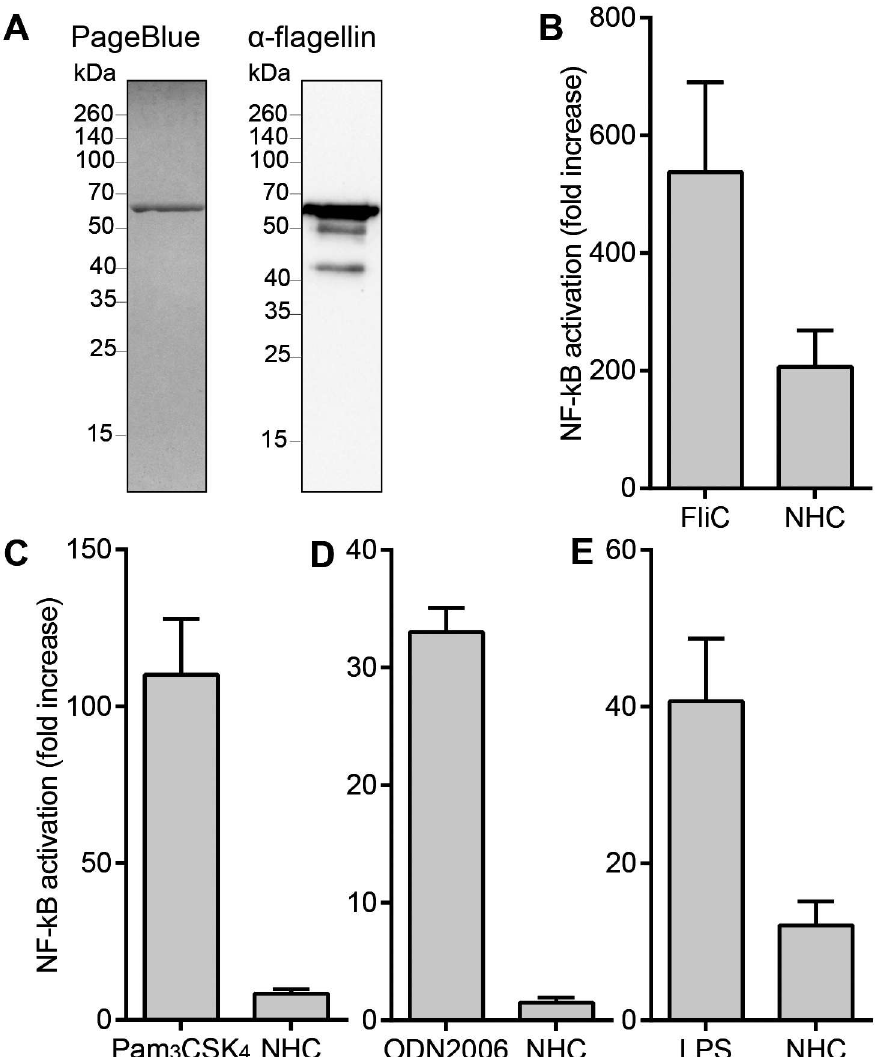
Fig 1. Quality properties of the NHC vaccine. ( A ) The NHC protein was analyzedby SDS-PAGE in combination with PageBlueProtein Staining and by Western blotting using a C . jejuni 81116 FlaA flagellin- specific antibody. ( B-E ) NF- κ B luciferaseactivity of HeLa57Acells expressing ( B ) chTLR5, ( C ) chTLR2t2/ chTLR16, ( D ) chTLR21 and ( E ) chTLR4, after stimulation (5 h) with NHC flagellin or the respective positive controls. Results are expressedas fold increase in stimulated cells versus non-stimulated cells and represent the mean ± SEM of three independent